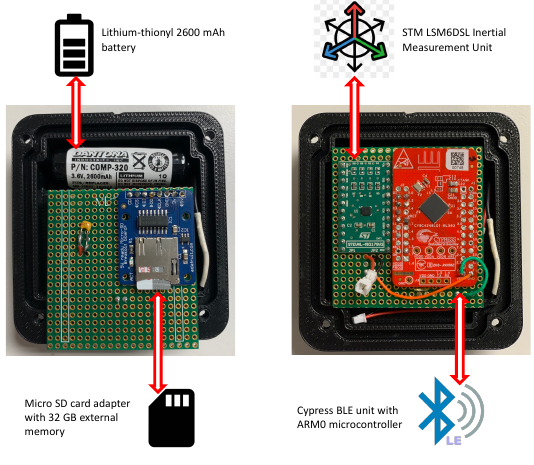
Figure 1. System